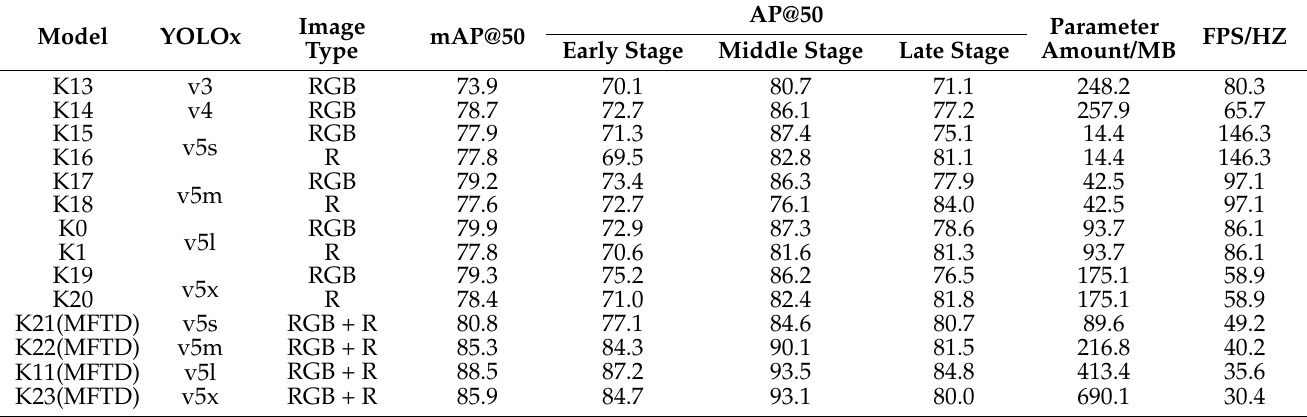
Table 8. Detection performances of YOLO series and MFDN on KP Dataset.